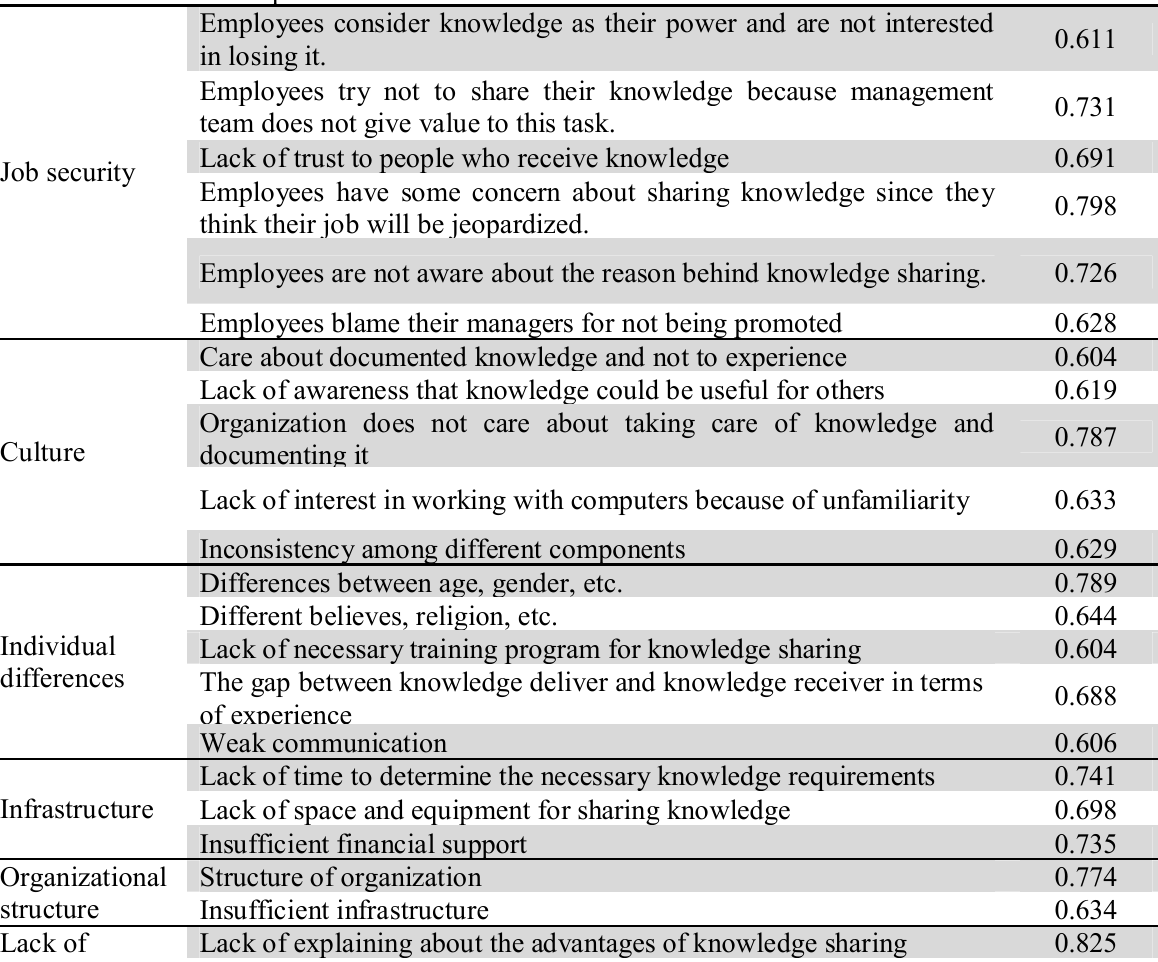
The summary of the results of factor loading on barriers for knowledge management implementation